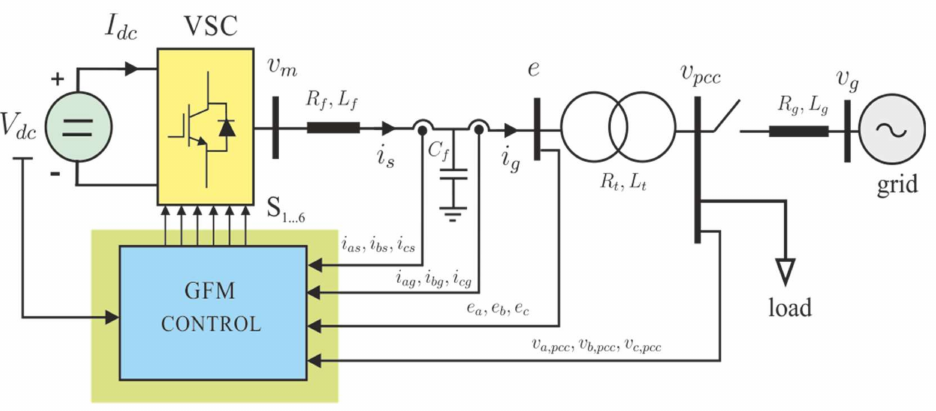
Figure 1. System description of a GFM-controlled VSC connected to a